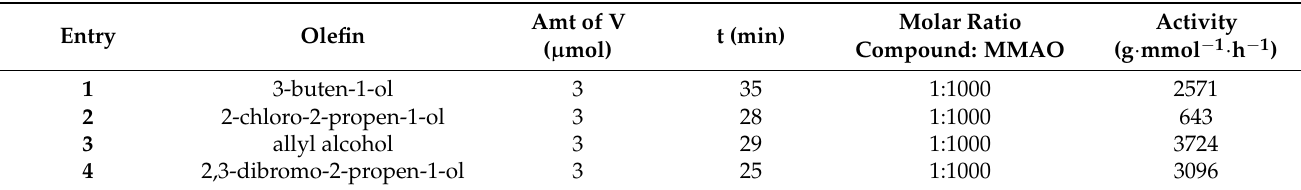
Table 3. Data for the oligomerizations of selected olefins using new oxovanadium(IV) microclusters with 2-phenylpyridine activated by